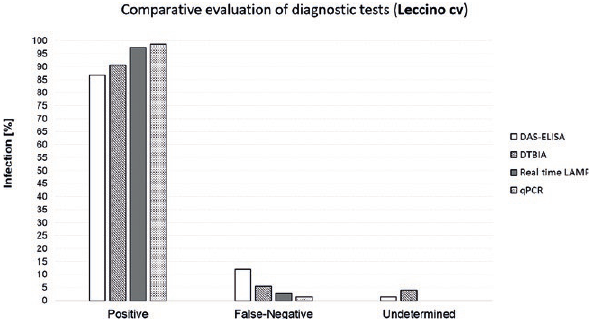
Figure 9. Infection levels indicated in diff erent Xylella fastidiosa diagnostic tests (DTBIA, DAS-ELISA, qPCR, real-time LAMP), expressed as percentages of positive, false-negative and undeter- mined